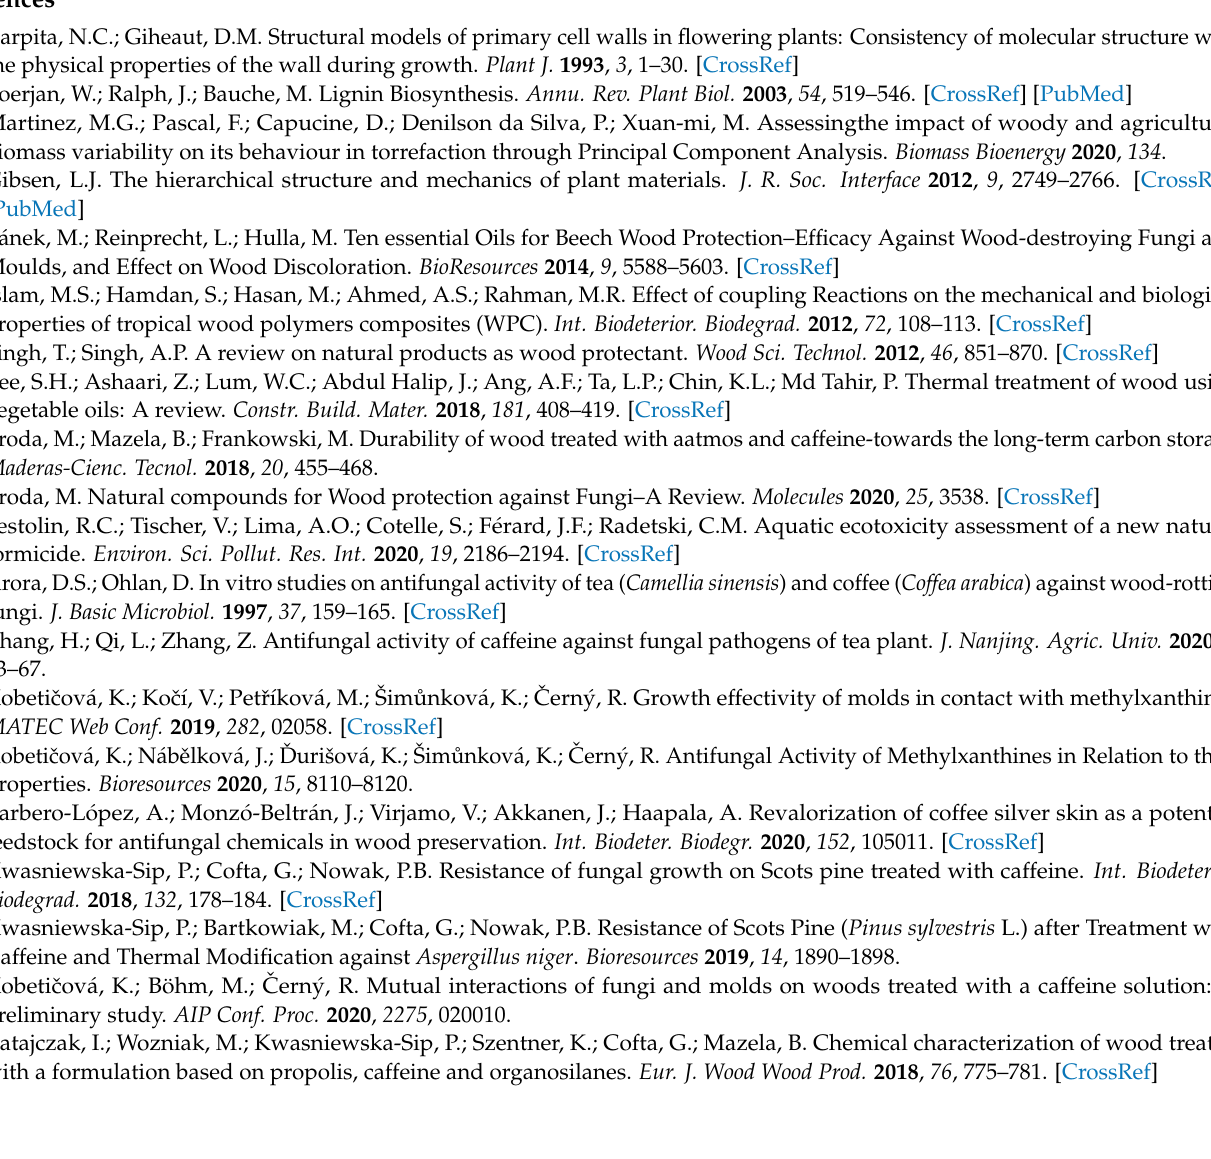
conipheryl alcohol, C—cellulose, SA—sinapyl alcohol. Table S3. Data of Tukey-Kramer Multi- ple Comparisons Test (Anova)—comparison of main wood components lignin (L), cellulose (C), and hemicellulose (HC). Table S4. Data of Tukey-Kramer Multiple Comparisons Test (Anova)— comparison of lignin (L) with its the precursors (CuA—coumaryl alcohol, CoA—conipheryl alcohol, SA—sinapyl